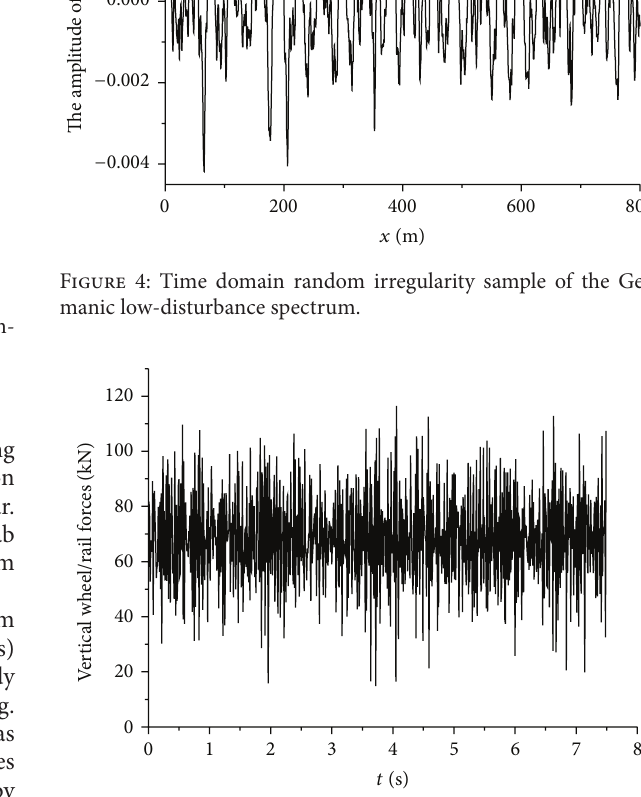
Figure 5: Time history of vertical wheel/rail